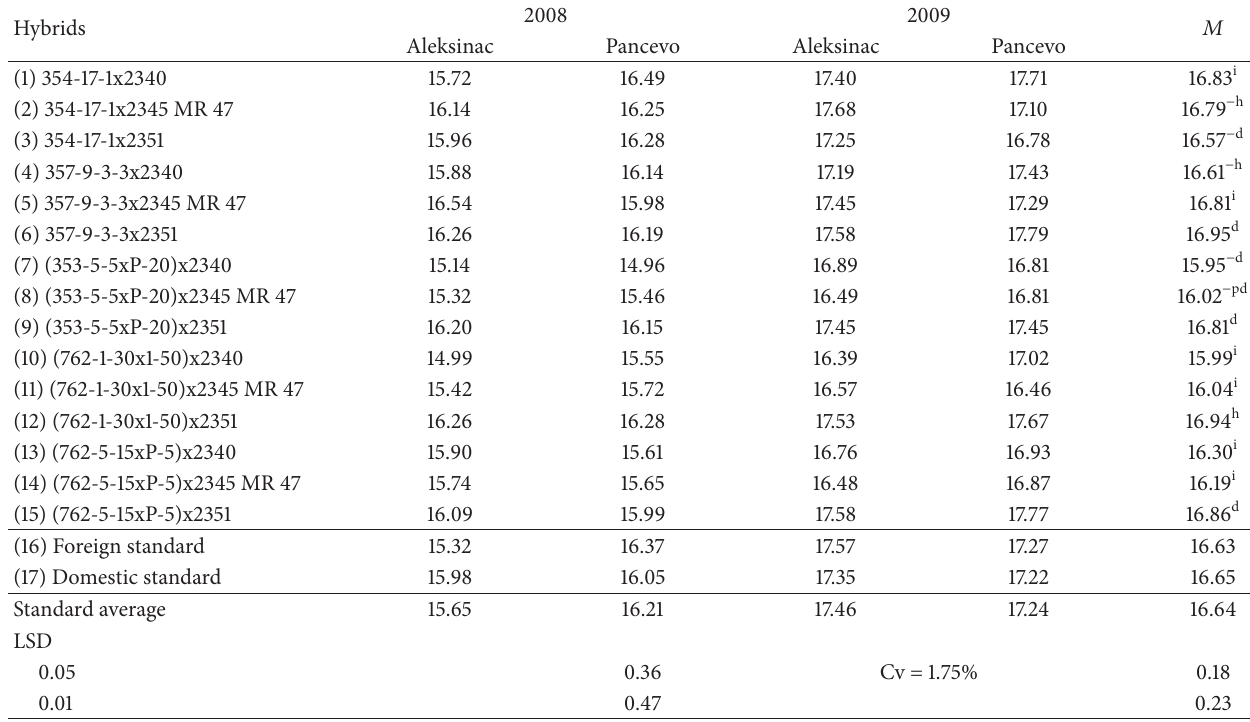
Table 5: Mean values and the mode of inheritance of sugar content (%) for parents and hybrids. Hybrids